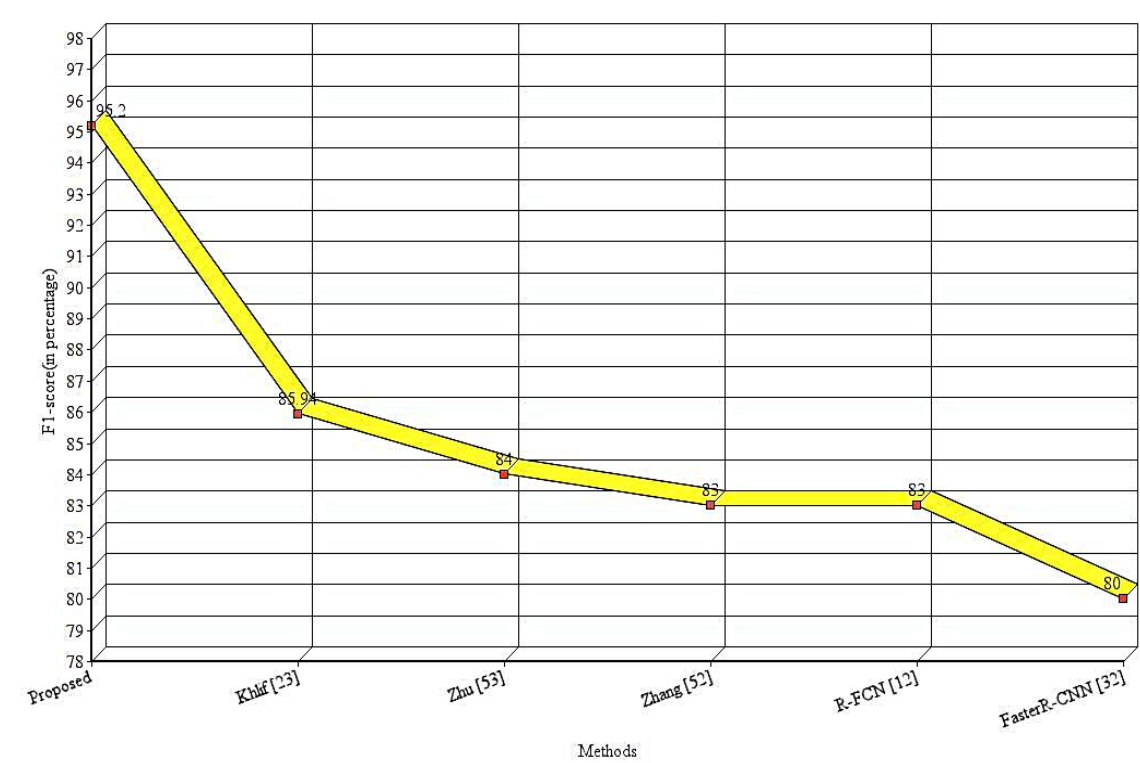
Figure 11. Comparison of F1-score for proposed and existing methods